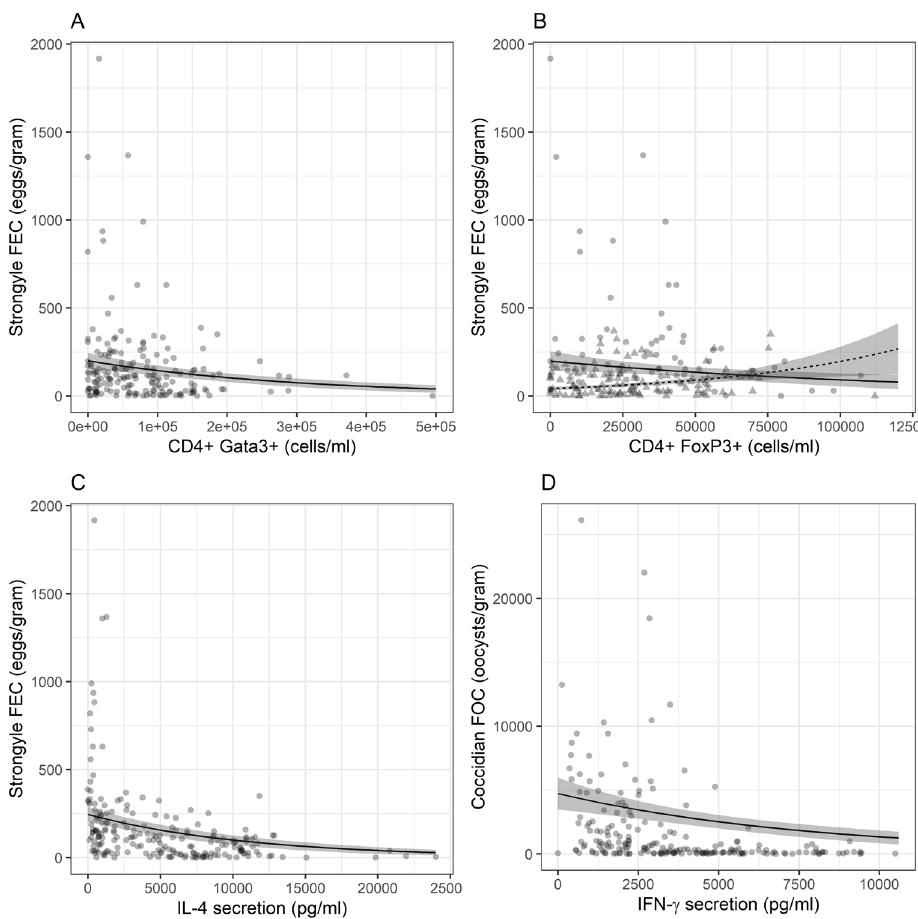
Figure 4. Associations between strongyle faecal egg count (FEC) and ( A ) total CD4 + Gata3 + cells; ( B ) total CD4 + Foxp3 + cells; ( C ) IL-4 secretion; and between coccidian faecal oocyst count (FOC) and ( D ) IFN-γ secretion. Points show raw data and lines show predictions from models in Table 1. In ( B ), lambs are represented by circles and broken lines, adults by triangles and unbroken